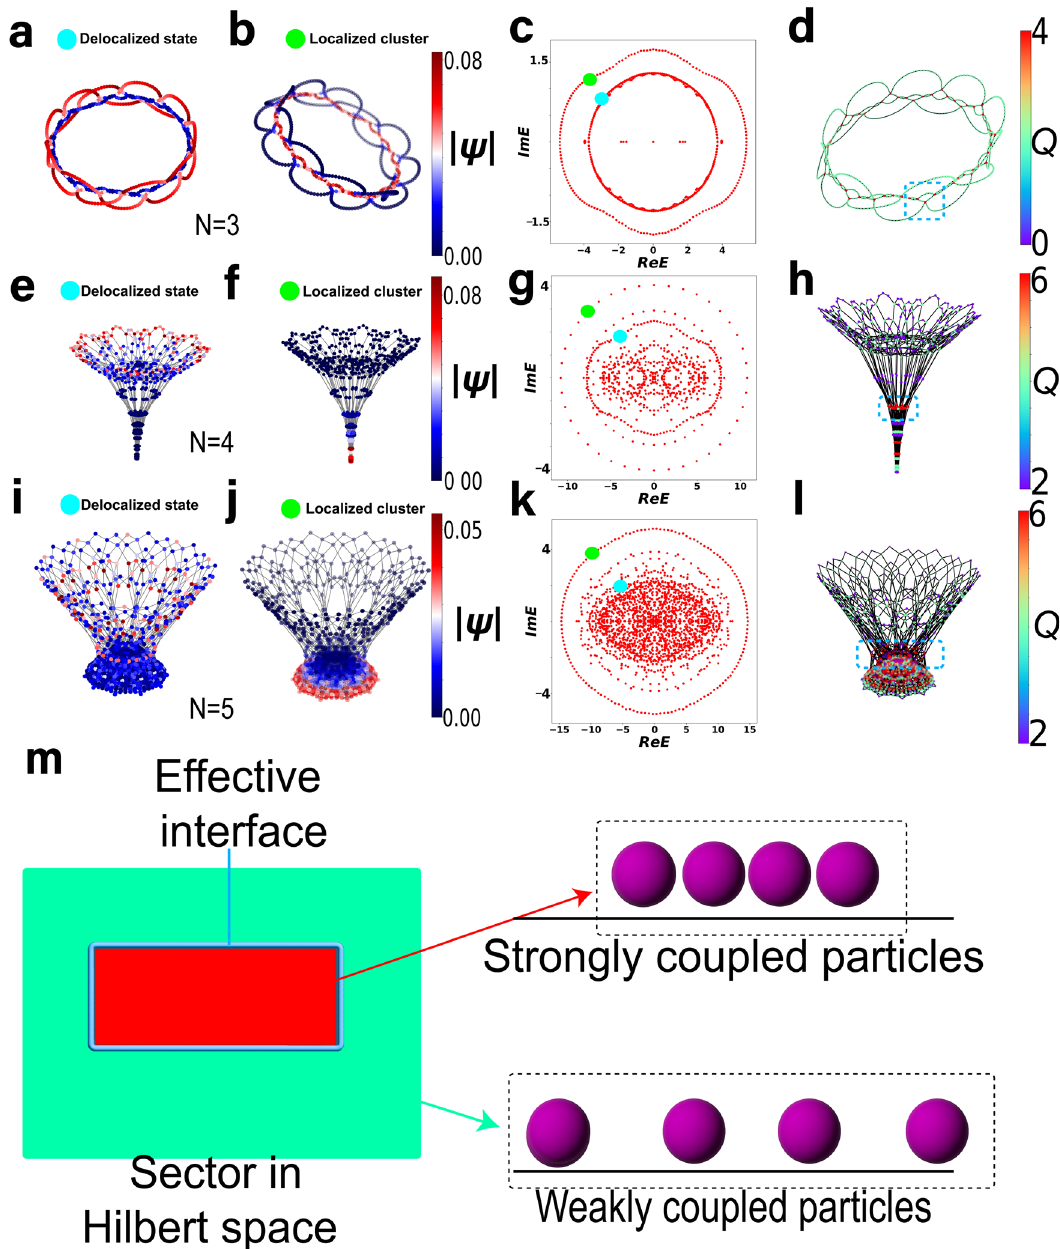
Fig. 5 Generalization of the effective interaface in the Hilbert space for the discussion in subsection "Effective interface and clustering in many-body sectors." from the section "result and discussion". Many-body Hilbert space graphs and the densities of selected cluster and delocalized non-cluster states in N = 3, 4, 5-boson sectors under periodic boundary conditions (PBCs). Plot a represents the delocalized state (state indicated by the light blue dot in c ), and plot b depicts the localized cluster state (state indicated by the green dot in c ). Plot a and b share the same color bar, which represents the amplitude of the wavefunction ∣ ψ ∣ at each node. c is for the spectra under PBCs with the selected states for a and b . In plot d , the effective boundary highlighted in blue dashed box is the red region of higher connectivity (no. of graph neighbors Q identi fi ed in the color bar) that separates regions of relatively low connectivity. The representations for e – h and i – l follow the manner of the plots a – d . According to a – l , we fi nd that localized cluster states always lie on the outer spectral loop regardless of the number of bosons N . Also, they always lie next to effective boundaries, which are regions of highest connectivity on the Hilbert space graph that also separates regions of relatively high and low connectivity. m Schematic notion of an “ effective interface ” in a Hilbert space graph: by separating regions of different levels of connectivity, it is physically interpreted as a demarcation between strongly and weakly coupled particles. The size and fi lling are a – d L = 20, N = 3; e – h L = 10, N = 4; i – l L = 10, N = 5. Parameters are t 1 = 1.4, t 2 = 1.2, γ = At the boundary, the OBC boundary condition gives From them, we can obtain the solution to the zero mode of SSH chain as = 0, β = ( t + γ )/( γ − t ψ 1 B 1 2 ). Figure 6b presents a zero mode in the effective SSH chain while Fig. 6c presents its corresponding squared amplitude in physical space, as a two-boson system. Similarly, the three-boson sector can be mapped to a two- dimensional non-Hermitian model as shown in Fig. 1d. See more details of the effective two-dimensional non-Hermitian model in Supplementary Note 1.